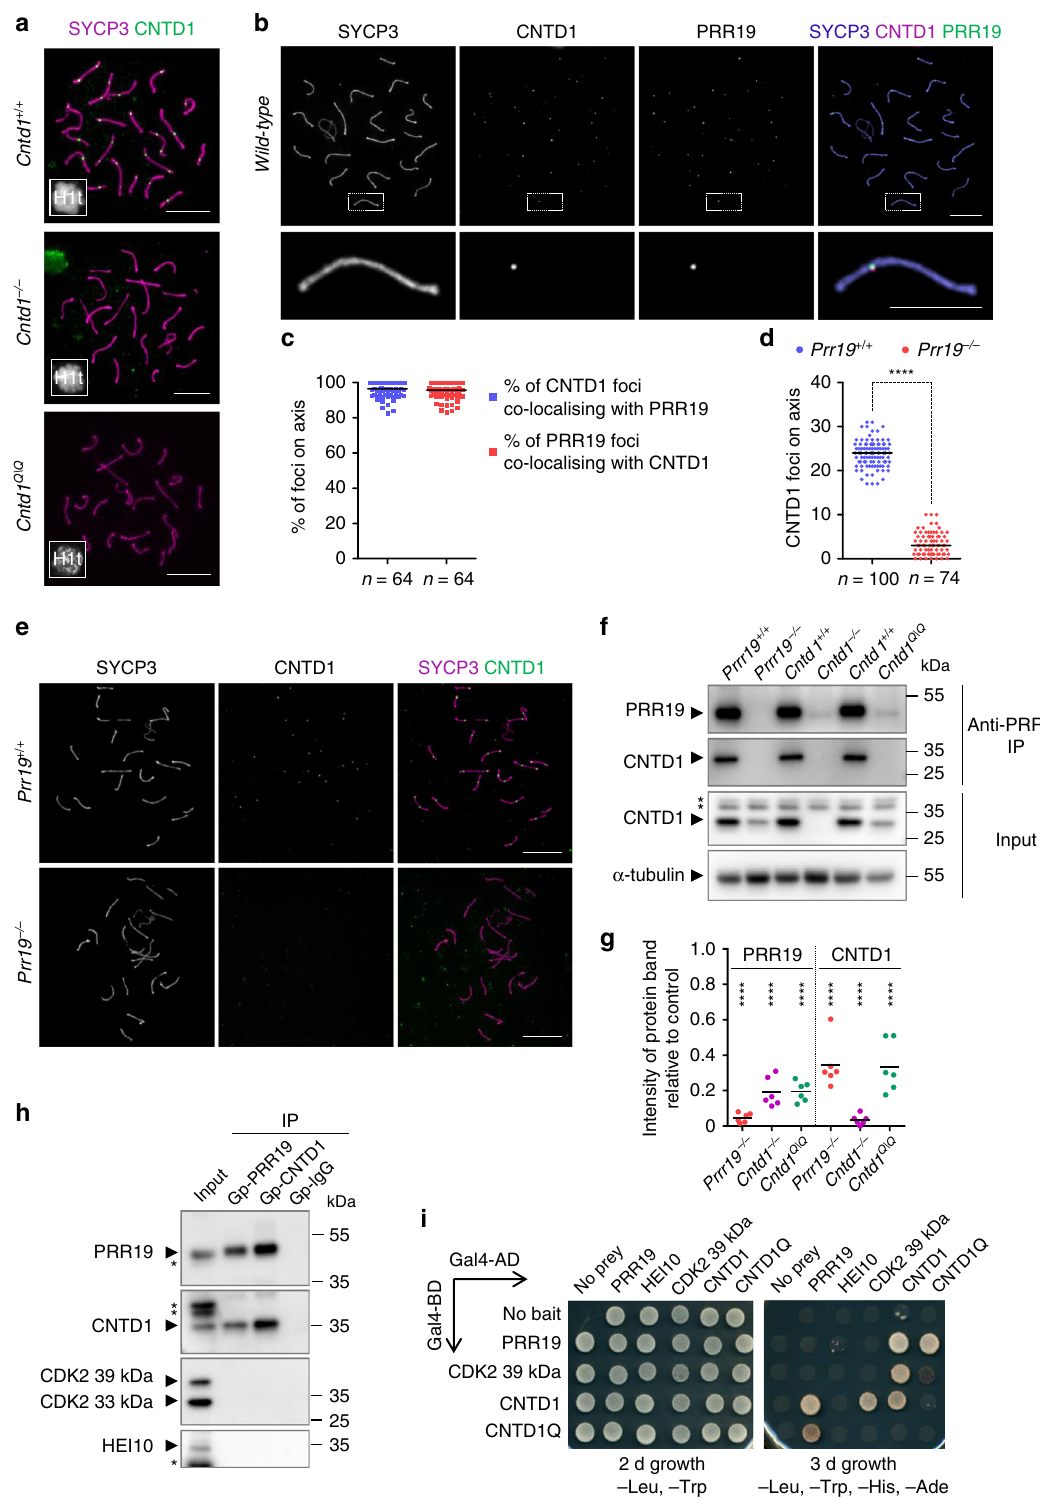
mechanisms 35,47 . One of these is activated by a de fi ciency in the formation of the sex body, the transcriptionally silenced chro- matin domain that encompasses the unsynapsed non-homologous regions of the X and Y chromosomes. Sex bodies form in wild- type spermatocytes by the silencing of unsynapsed chromo- somes 35 , which depends on HORMAD1/HORMAD2-mediated enrichment of ATR activity in unsynapsed chromatin 48 – 52 .